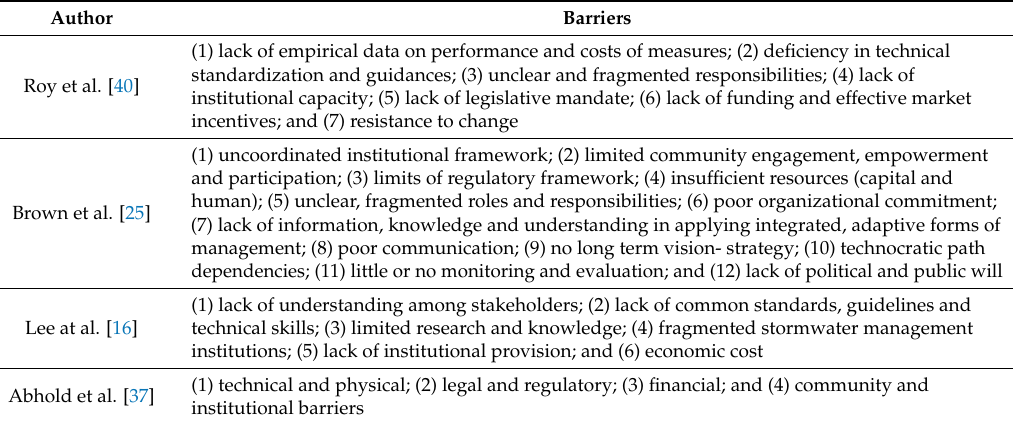
Table 2. Barriers to green infrastructure implementation as identified by various